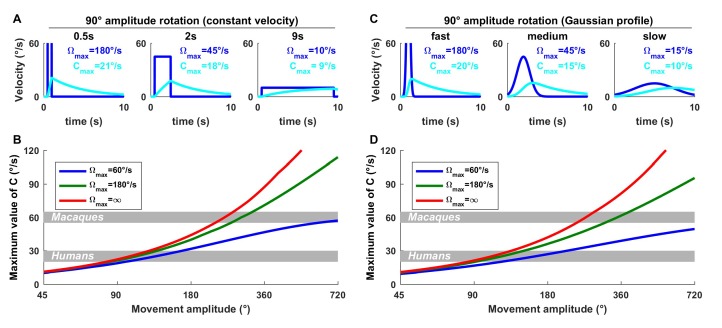
Quantitative analysis of the importance of an internal model of the canals for ecological movements.The internal variable C, which represents the difference between head angular velocity and the canal signal V, and needs to be estimated by the internal model of the canals for accurate velocity perception, has low-pass dynamics. Nevertheless, its importance is highest for high velocities. To illustrate this, here we simulate C during either (A,B) constant velocity or (C,D) Gaussian-velocity rotations of various amplitudes and durations. (A,C) Rotations with an amplitude of 90° and duration of 0.5, 2 and 9 s (i.e. rotations at 180, 45 and 10°/s, respectively). We find that the peak value of C is, 21°/s during a fast movement (0.5 s), whereas it is only 9°/s during a slow movement (9 s). Therefore, for a given movement amplitude, the internal model contribution is larger at larger velocities. (B,D) Maximum value of C as a function of movement amplitude for slow (60°/s) and rapid (180°/s, and infinite velocity) movements. During fast movements, C may exceed 20°/s during 90° rotation and 40°/s during 180° rotation. We note that the velocity storage likely saturates at ~20–30°/s in humans (Laurens et al., 2011) and ~60°/s in macaques (Waespe et al., 1983) (shown in B and D as gray bands; this saturation is not included in the Kalman filter). For fast rotations (180°/s or more), the saturation would be reached for rotations of 130° in humans (assuming a saturation velocity of 30°/s) and 290° in macaques. These simulations demonstrate that the role of the velocity storage in compensating for canal dynamics is not restricted to long-duration rotations but encompasses natural movements.